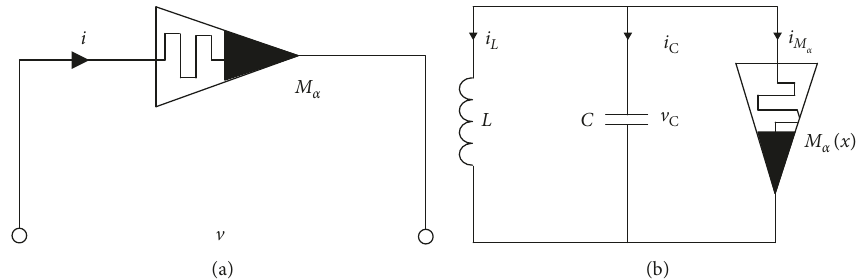
Figure 1: (a) The fractional-order memristor M